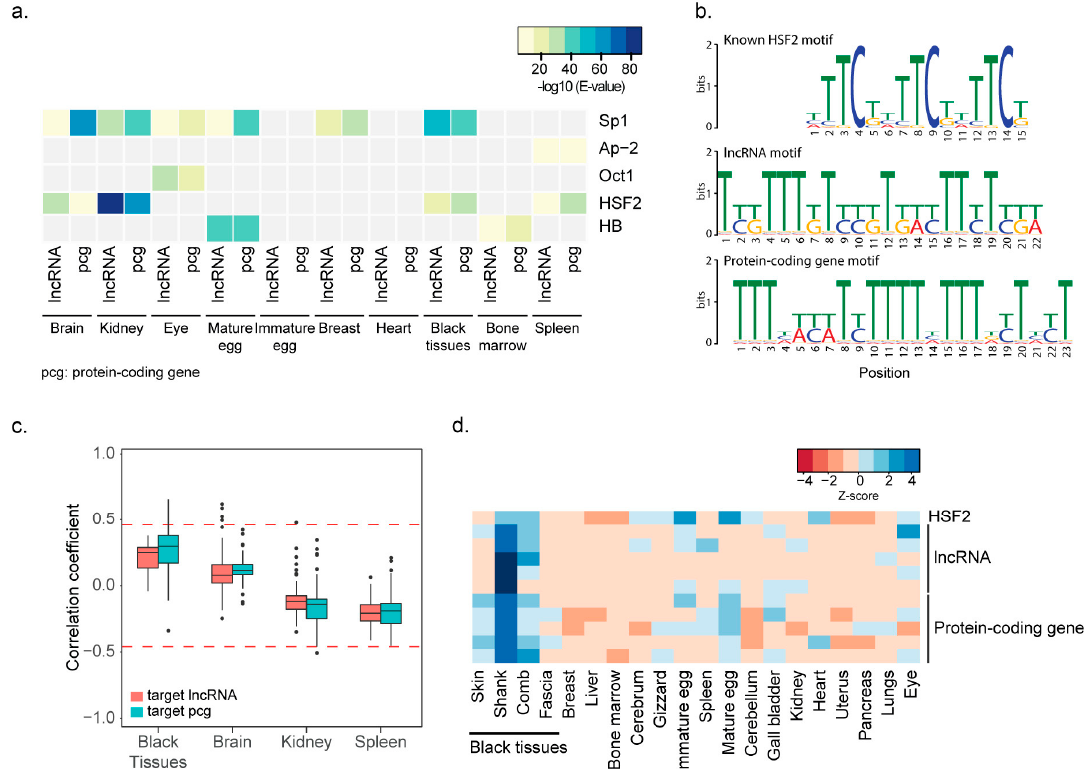
Figure 4. Co-transcriptional regulation of lncRNA and protein-coding genes by common TFs. ( a ) TFs (Sp1, Ap-2, Oct1, HSF2, and HB) with binding motifs significantly co-enriched in the promoters of lncRNAs in a tissue-specific cluster and their co-expressed protein-coding genes are shown in the heatmap. The TFs are expressed in the indicated tissues. The significance of motif enrichment was tested using MEME and E values are presented with color codes (blue: more significant, yellow: less significant) in the key. PCG indicates protein-coding gene. ( b ) HSF2 binding motif. A known motif is shown in the top panel, motif in lncRNA promoters is shown in the middle panel, and motif in protein-coding gene promoters is shown in the bottom panel. ( c ) The expression correlation between co-regulated genes (red boxes for lncRNAs and green boxes for protein-coding genes) and HSF2 across tissues. Red lines indicate the significance level of the correlation coefficient ( p ≤ 0.05). ( d ) Expression pattern of HSF2 and its target genes showing the top 5 correlations with HSF2 .